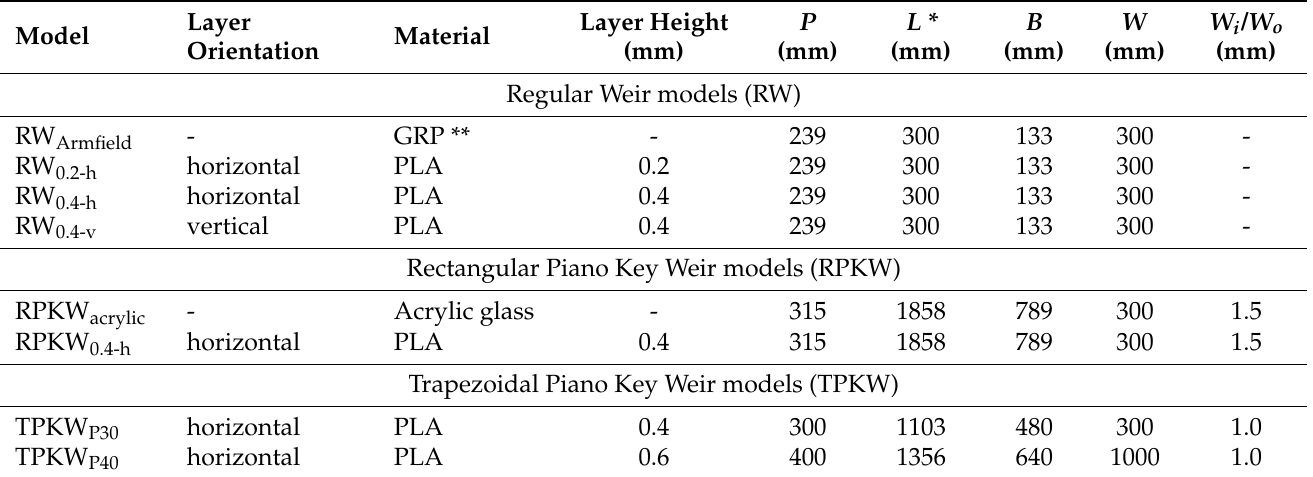
Table 1. Summary of model specifications.